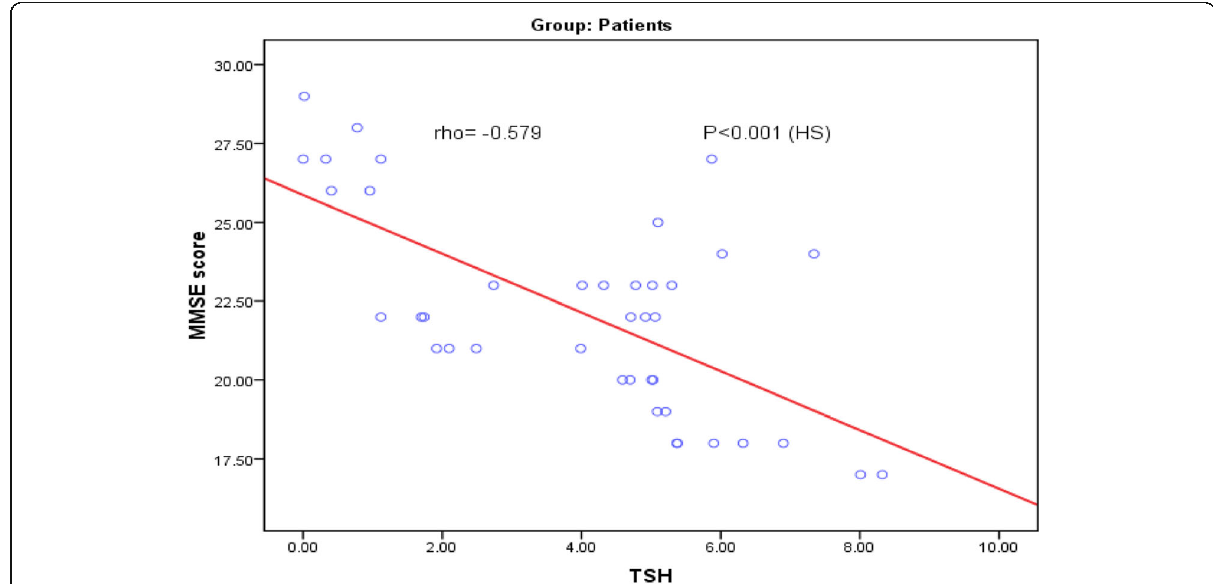
Fig. 1 Scatter graph showing a highly significant negative correlation between TSH and MMSE